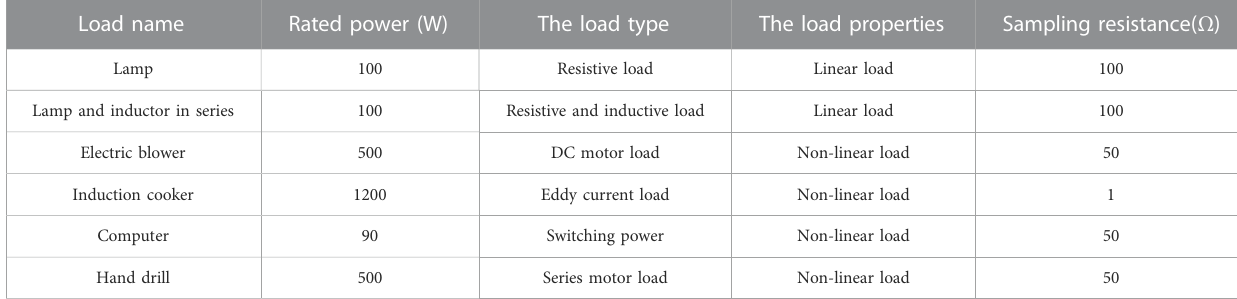
TABLE 1 Load parameters and sample resistance